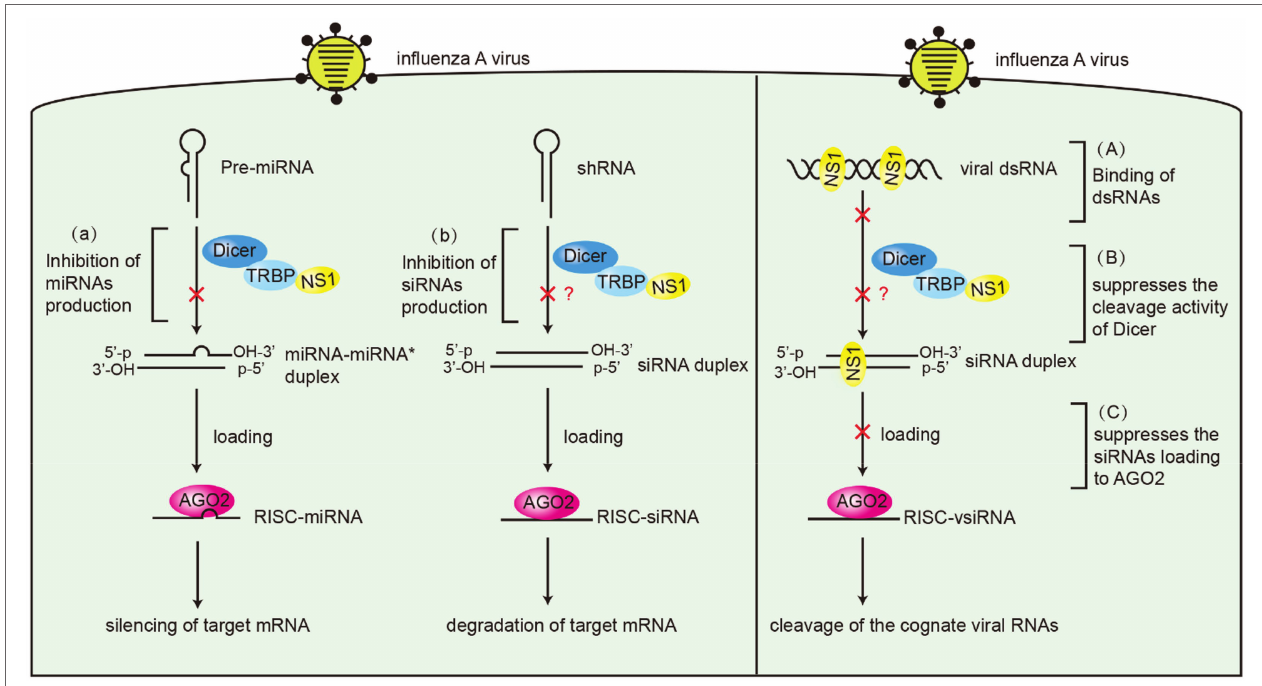
FIGURE 9 | Schematic model of the suppressor roles of NS1 in RNAi. Left panel: (A) NS1 inhibits miRNAs production by interacting with TRBP. (B) NS1 inhibits shRNA-mediated RNAi by interacting with TRBP. Right panel: (A) NS1 inhibits siRNA production by directly binding to dsRNAs. (B) NS1 suppresses the cleavage activity of Dicer by interacting with TRBP. (C) NS1 suppresses siRNA loading onto AGO2 by directly binding to